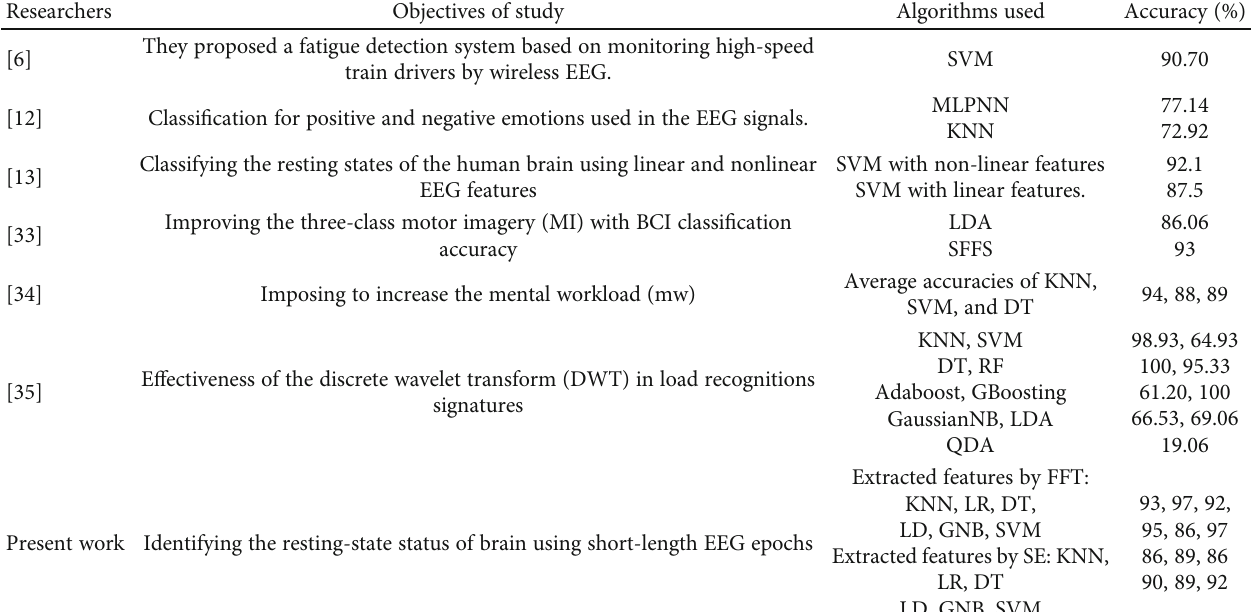
Table 6: Di ff erent results of di ff erent objective studies compared with our